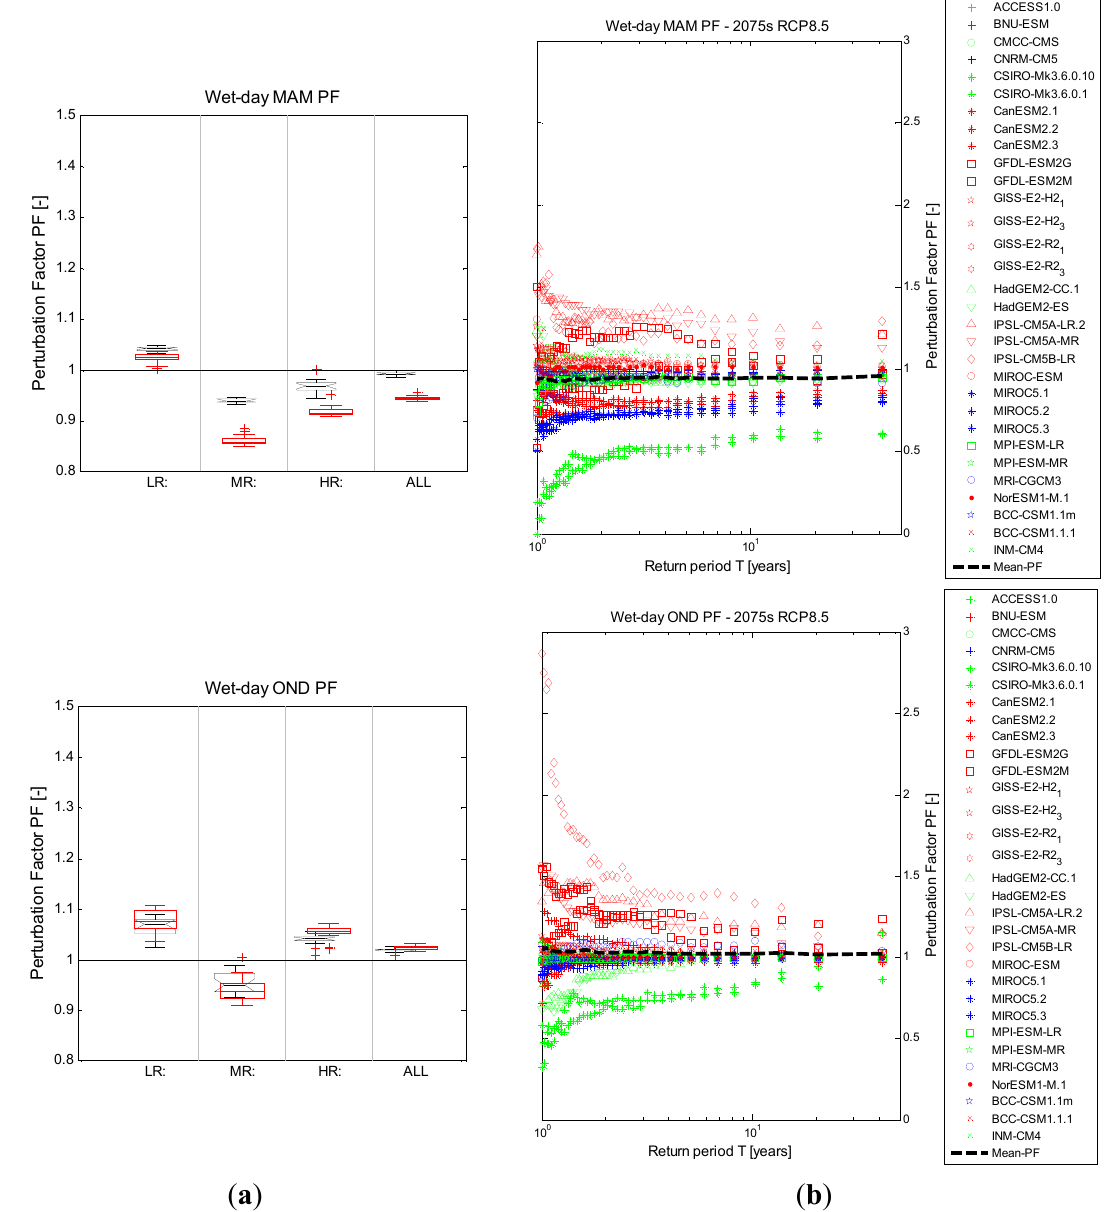
Figure 13. ( a ) Perturbation factors for number of wet days simulated by GCMs in the different seasons for the 2040s (notched) and 2075s, for RCP8.5; ( b ) Perturbation factors vs. return period for number of wet days simulated by the GCMs in the 2075s for RCP8.5 in different seasons, Red = LR GCMs, Blue = HR GCMs and Green = MR